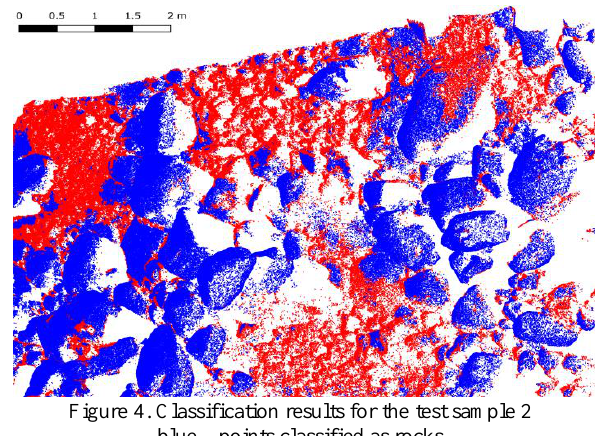
Figure 4. Classification results for the test sample 2 blue – points classified as rocks red – points classified as